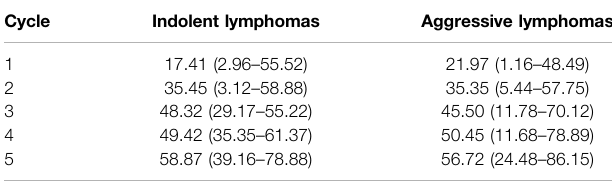
TABLE 4 | Rituximab trough concentration (µg/ml) for patients with indolent lymphomas and aggressive lymphomas in each cycle. Cycle